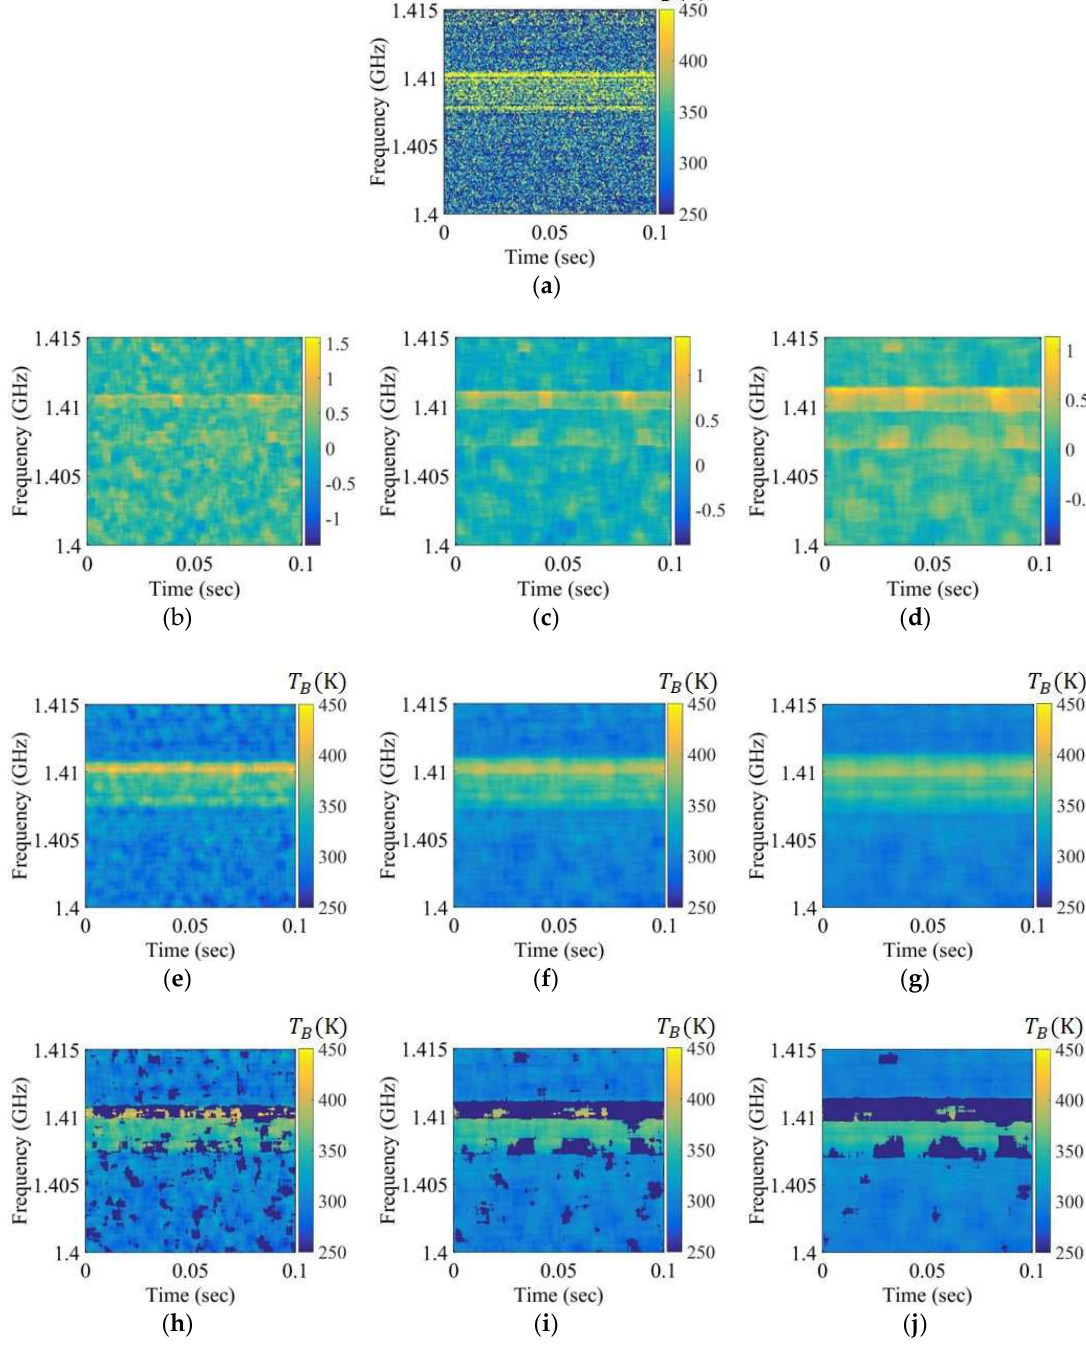
Figure 8. Spectrograms applied to the chirp RFI signal to a level below approximately 50 K over the entire 1.407 to 1.411 GHz band: ( a ) brightness temperature spectrogram after smoothing; ( b – d ) skewness spectrograms obtained using the window sizes of 50 × 50, 75 × 75, and 100 × 100, respectively; ( e – g ) mean spectrograms obtained using the window sizes of 50 × 50, 75 × 75, and 100 × 100, respectively; ( h – j ) mean spectrograms after Step 1 obtained using the window sizes of 50 × 50, 75 × 75, and 100 × 100, respectively.